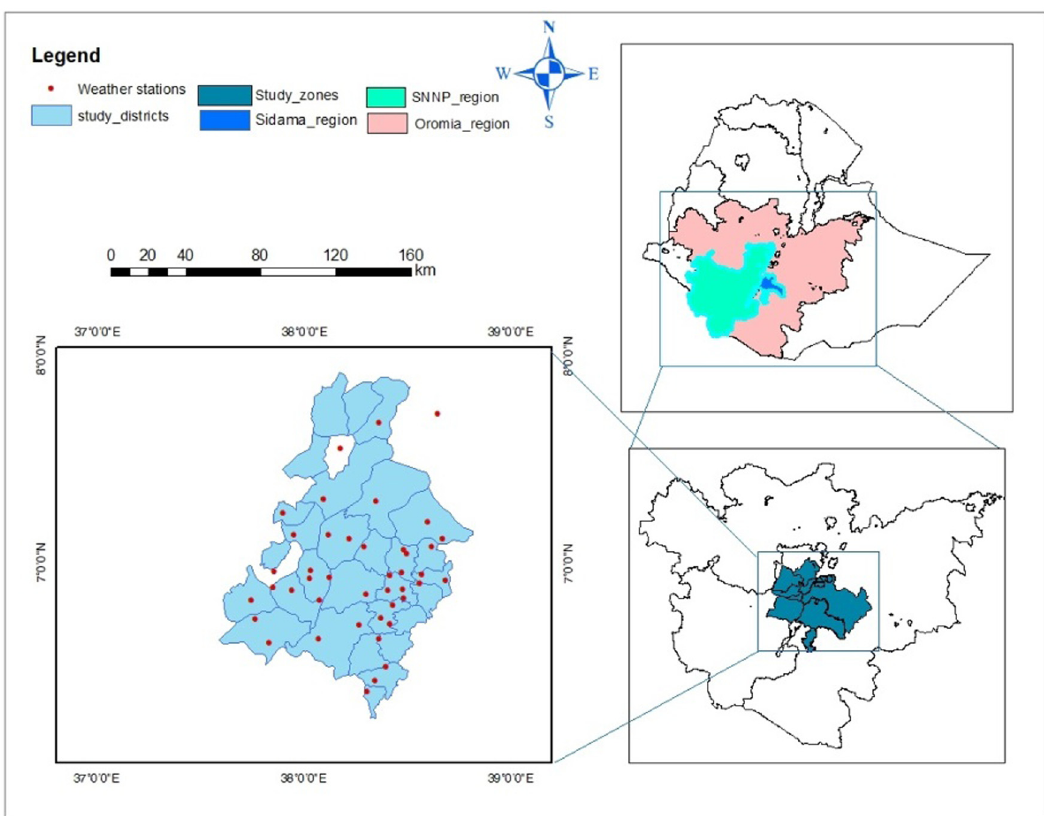
Figure 1: Study area and weather